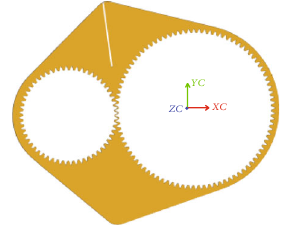
Figure 2: Fluid fi eld model of